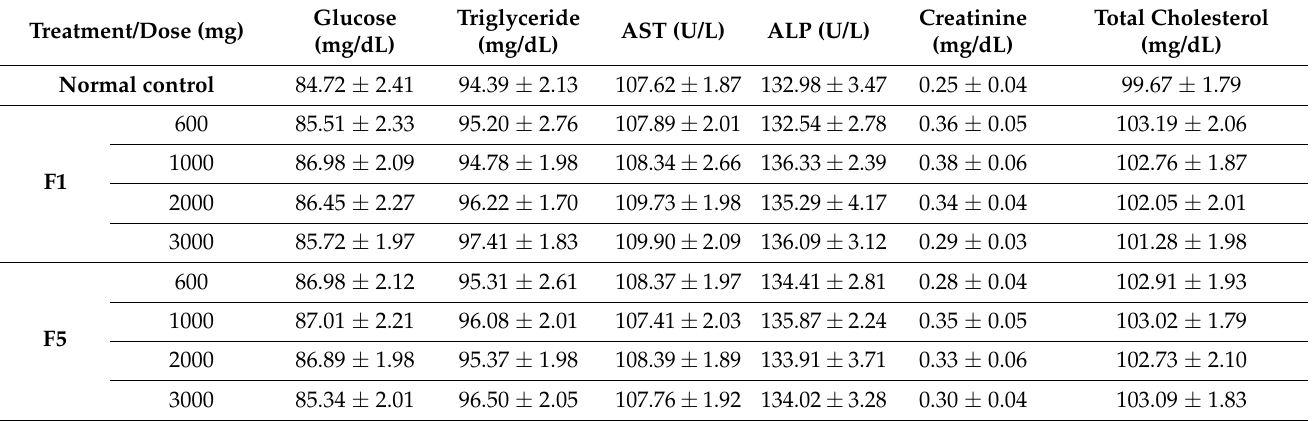
Table 4. The effect of flavonoids on biochemical parameters in acute toxicity assay.